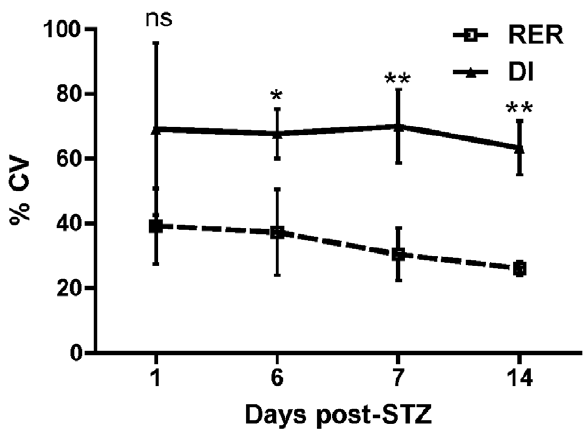
Figure 6. Reproducibility of the qMSP assay. The variability of the qMSP results at different time points as analyzed using Relative Expression Ratio (RER) compared with Demethylation Index (DI) at days 1, 6, 7, and 14 post-STZ treated mice. The data display the percent coefficient of variation (%CV) with standard deviation (SD) of the variation at each point representing data from at least 4 mice. The statistical significance at each time point was calculated by Two-Way ANOVA to compare RER and DI and the significance level indicated by asterisks (*, P , 0.05; **, P , 0.01). ns= non significant.